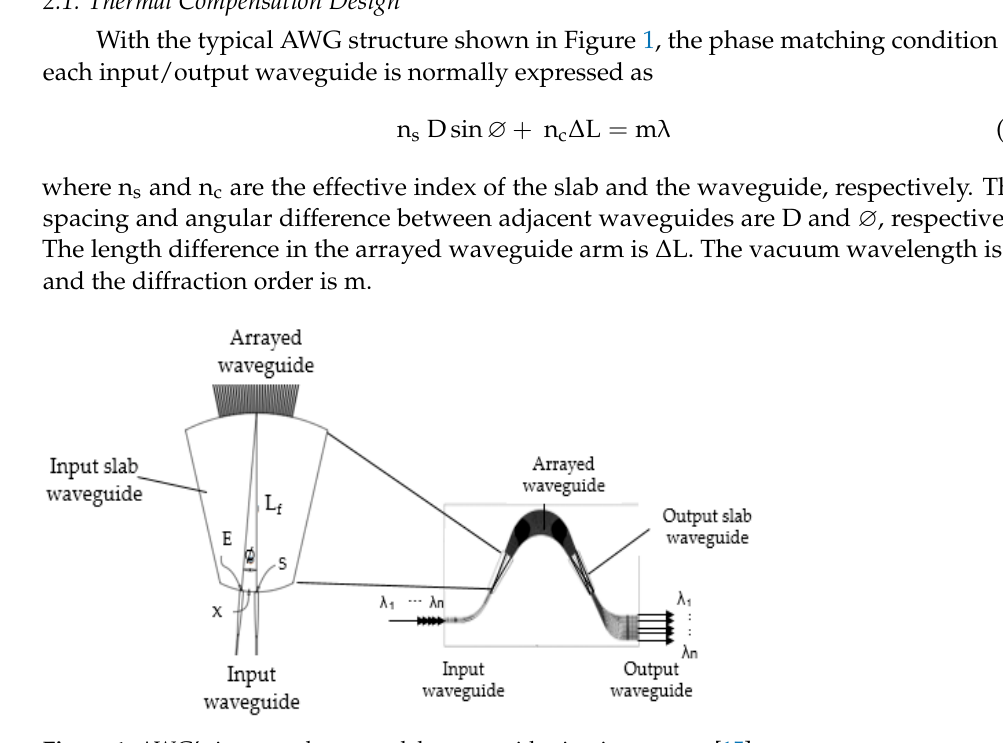
input wavelength from the C.W. For thermal compensation, the lateral displacement of the focal point ‘ dx’ for the temperature change ‘ dT ’ should be compensated by moving the